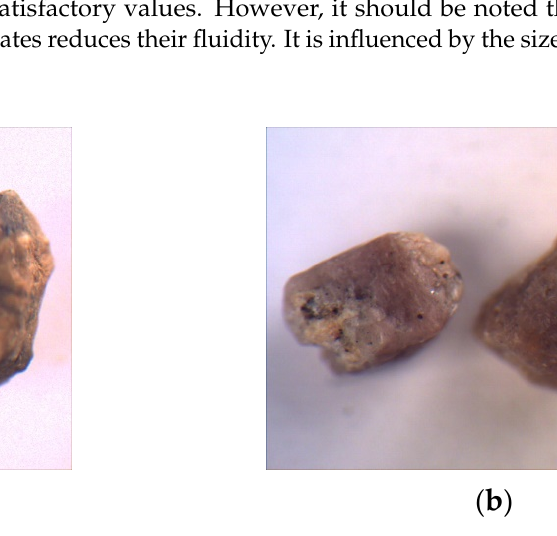
Figure 7. Macro photographs of sand particles: ( a ) dunite; ( b ) quartz. Quartz sand has a rounded shape without sharp corners. The shape of the dunite sand particles has a rough surface with numerous protrusions and depressions. This contributes to a tighter adhesion of the aggregates to the binder. The average density of concrete mixes also depends on the type of aggregate and has the lowest value for the standard sample (2371 kg/m 3 ). The main characteristic of the concrete quality is compressive strength since, by its change, you can observe changes in the microstructure of the hardened stone. This charac- teristic depends on aggregates added in the concrete composition [10]. The compressive strength of the samples (P) at the age of 7, 14, 28 and 90 days (the average value of three cubes) is shown in Table 5. The variation of the change in strength is estimated by charac- teristic α , which represents the ratio of the strength of the studied sample to the strength of the control sample at the respective hardening